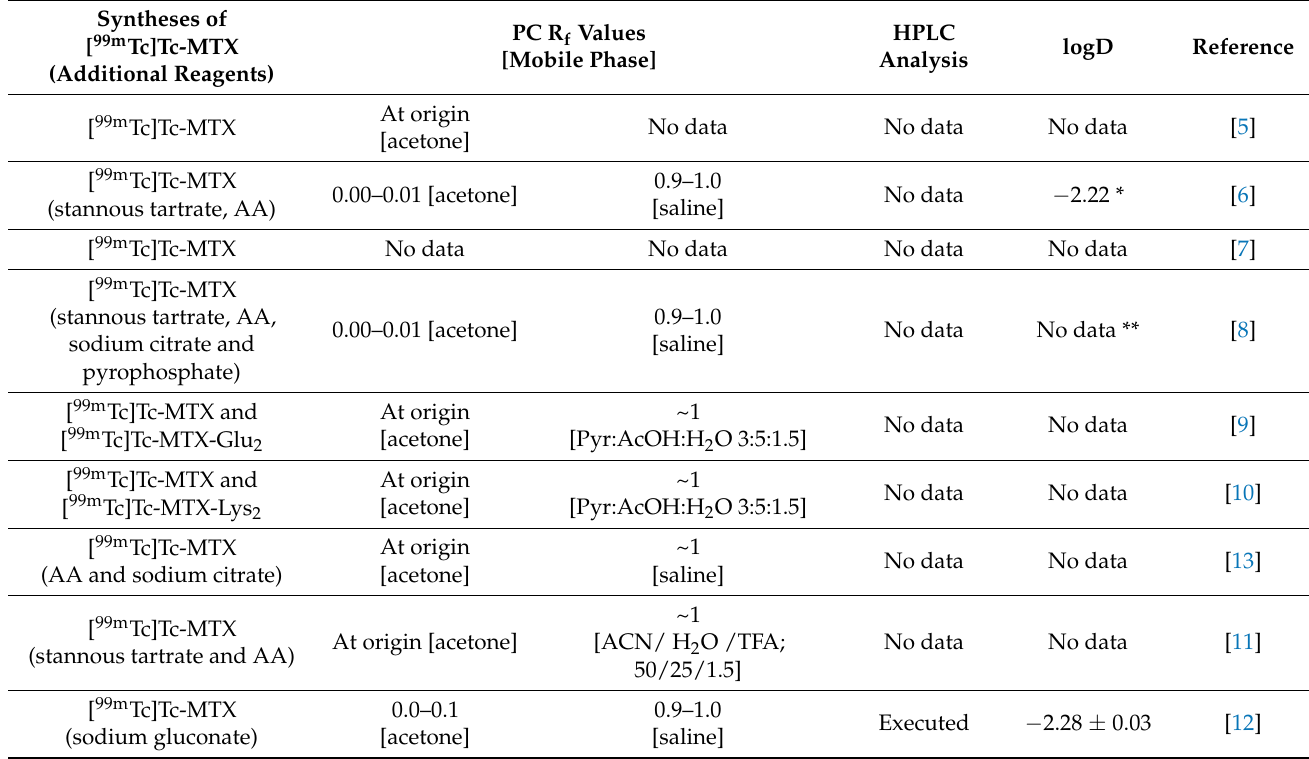
Table 1. Chromatography results and logD values of [ 99m Tc]Tc-MTX radiocomplexes obtained in the cited research